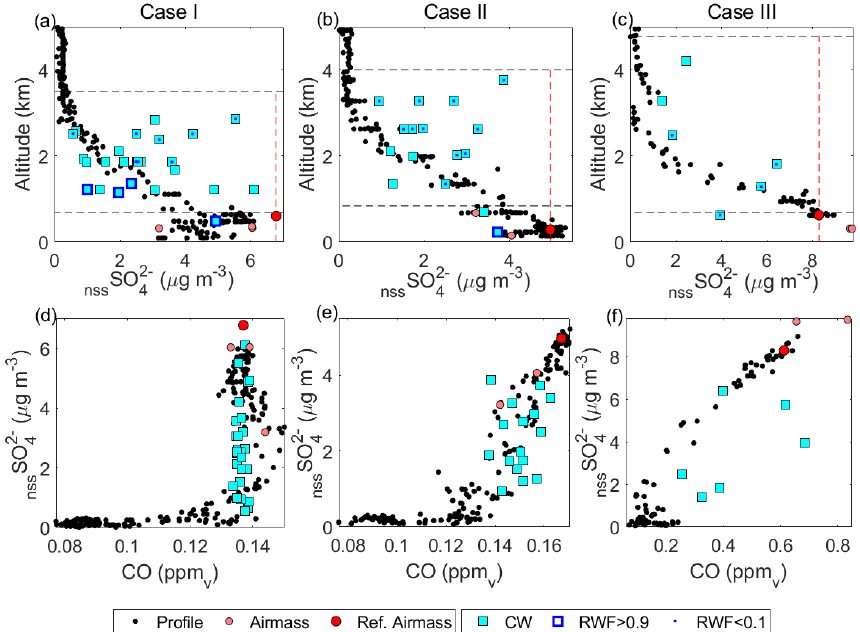
− and altitude for cloudy and clear-air samples in Cases I–III, respectively. Figure 6. (a–c) Profiles showing the relationship between nss SO 2 4 Profile data include a combination of spiral profiles in the vicinity of the cloud module as well as sections of the cloud module in clear air. AMS data (included for profiles for improved time response) were scaled for collection efficiency using a case-specific factor (see text). Air-mass data (PILS) are shown, and the reference air mass is highlighted with the vertical dashed line indicating the reference parcel (see text). Cloud water samples (cyan) are also distinguished as non-precipitating (RWF < 0.1) and rainwater (RWF > 0.9). For each case, an estimated cloud top and LCL are marked (dashed black lines). (d–f) Like panels (a) – (c) but showing the relationship between nss SO 2 − and 4 CO mixing